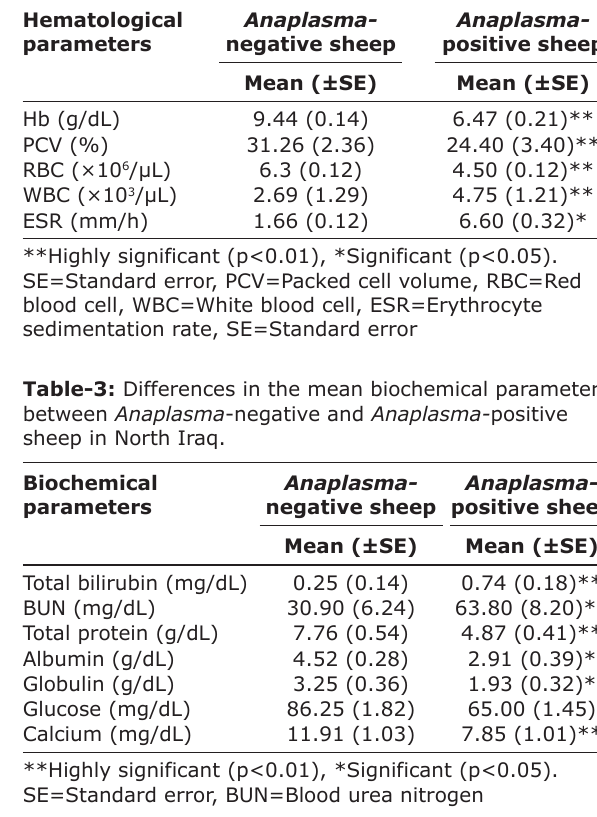
Table-2: Differences in the mean hematological parameters between Anaplasma negative and Anaplasma positive sheep in North Iraq.